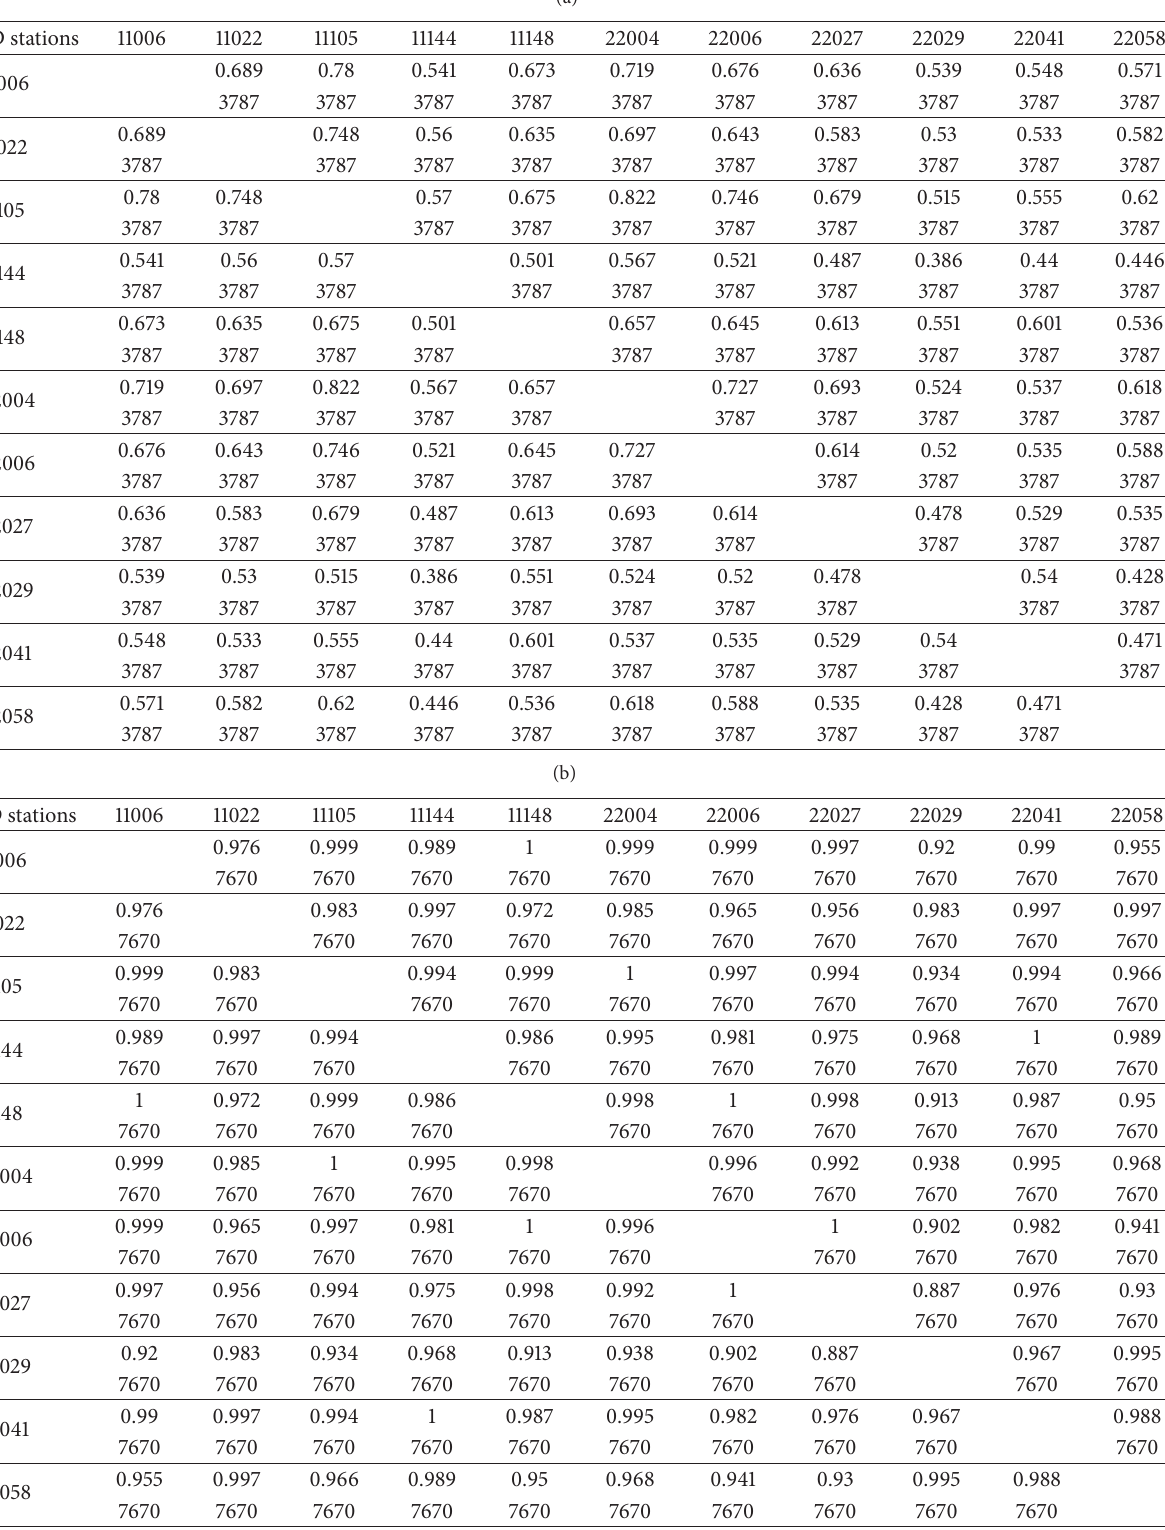
Table 1: Correlations of observed temperature data (a) and standardized residuals (b).